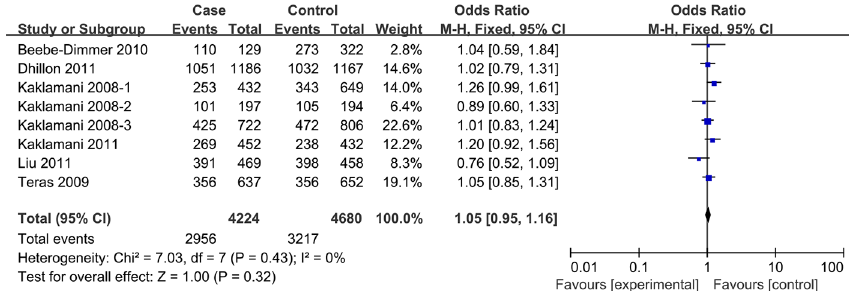
Fig 2. Forest plot of the association between ADIPOR1 SNP rs7539542(C/G) and cancer risk in a dominant model.